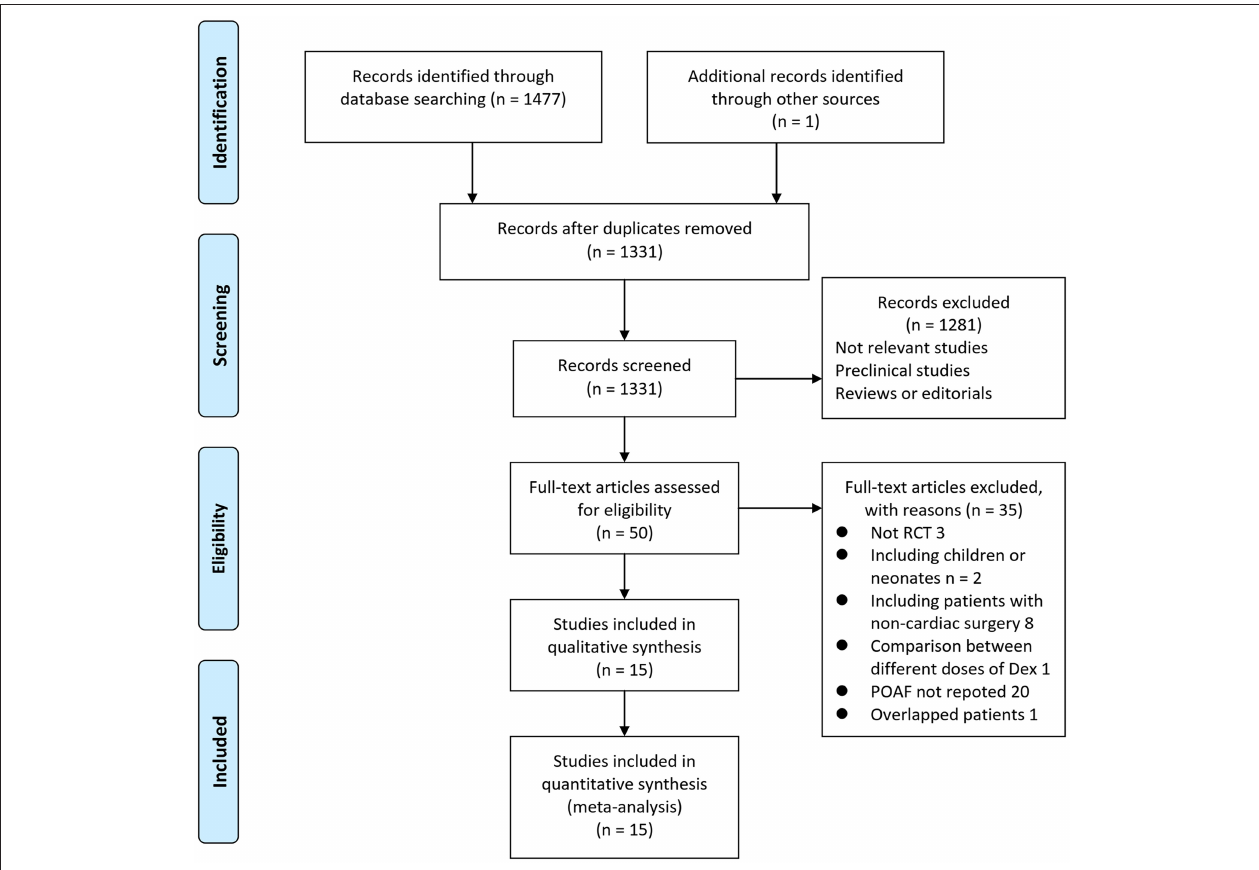
FIGURE 1 | Flowchart of literature